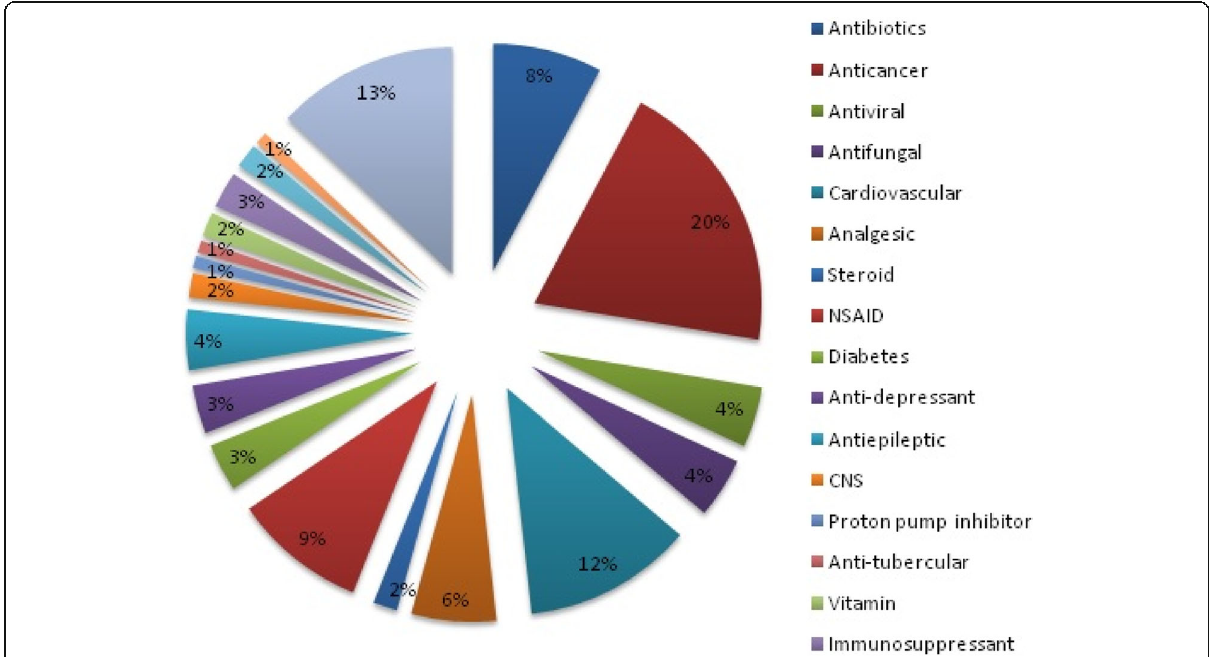
Fig. 2 Analysis of different classes of drugs using UHPLC-MS/MS in between 2006-2017